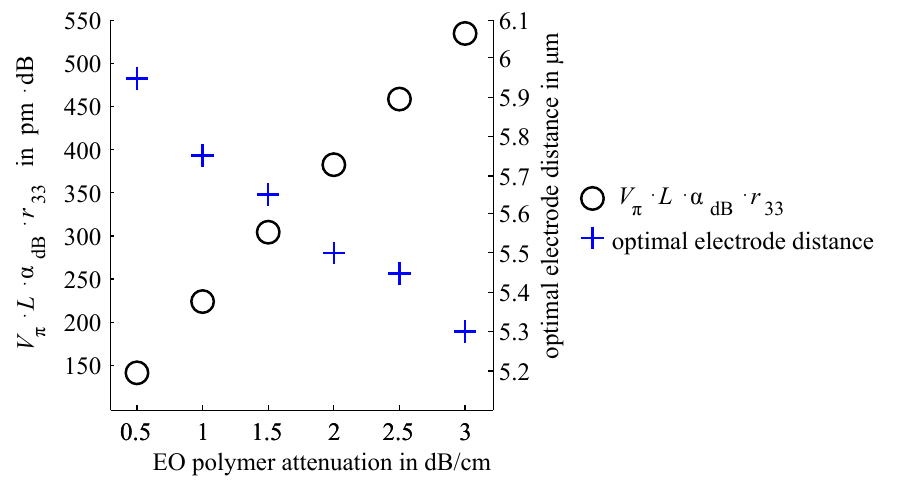
Figure 9. Simulation results, which show V π · L · α dB · r 33 and the optimal electrode distance in dependence of the EO polymer attenuation for the optimized waveguide